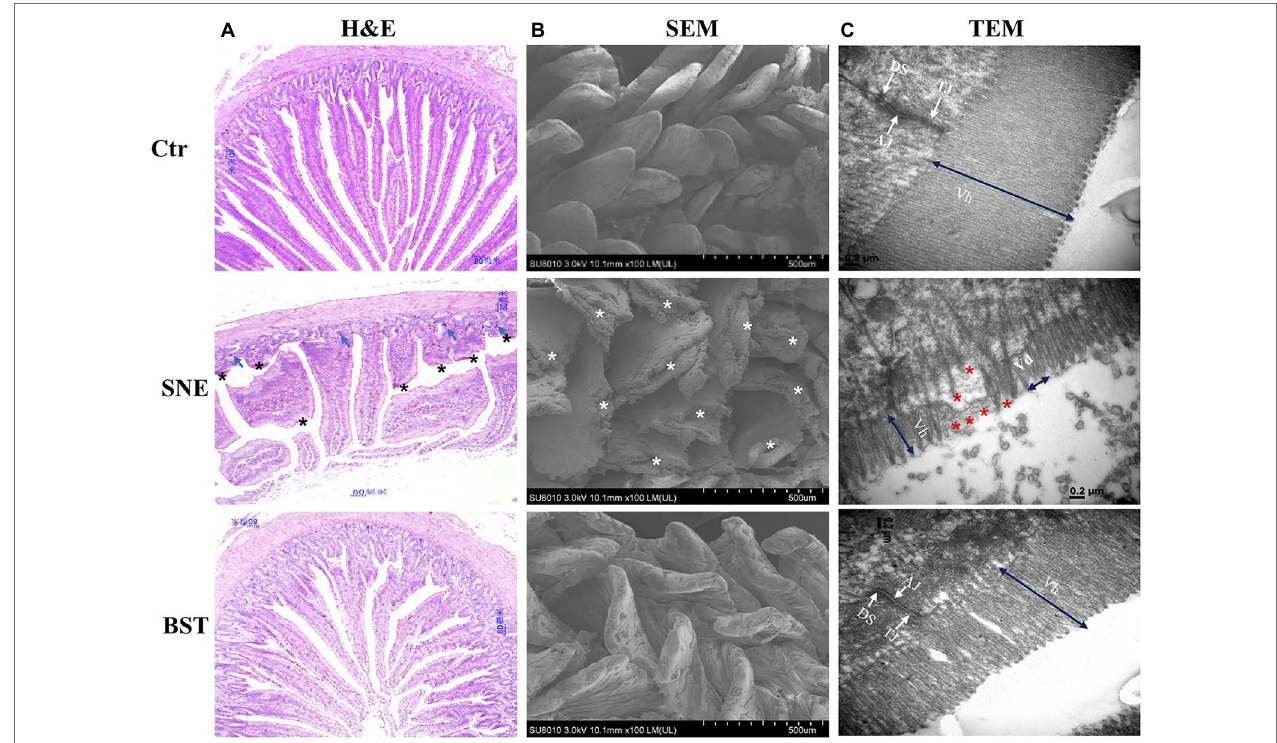
FIGURE 1 | (A) Representative haematoxylin and eosin (H&E)-stained images (top, scale bars = 80 μ m); (B) Scanning electron micrograph (bottom, scale bars = 500 μ m); and (C) Transmission electron microscopy (bottom, scale bars = 0.2 μ m) of jejunal mucosal surface of broilers orally treated with or without coccidia and Clostridium perfringens infection. Vh, Villus height; Vd, Villus density; TJ, tight junction; AJ, adherens junction; DS, desmosomes. Shows the pathological (asterisk). Numerous enterocytes show all the features of necrotic cell death (blue arrows). Ctr group, basal diet in control group; SNE group, basal diet + SNE (20-